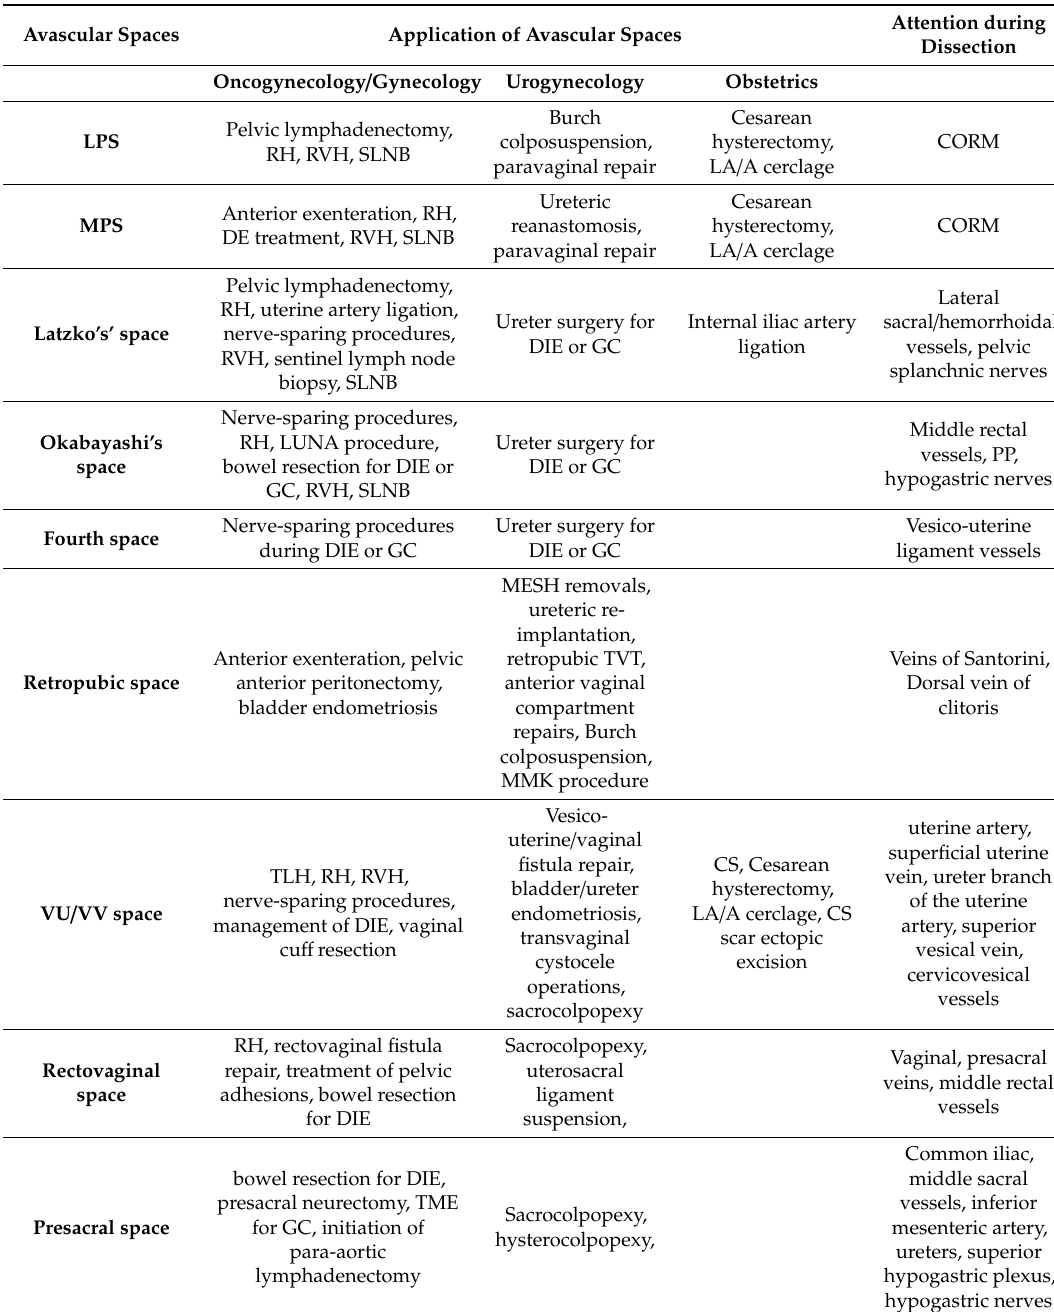
Table 1. Avascular spaces—applications and attention during